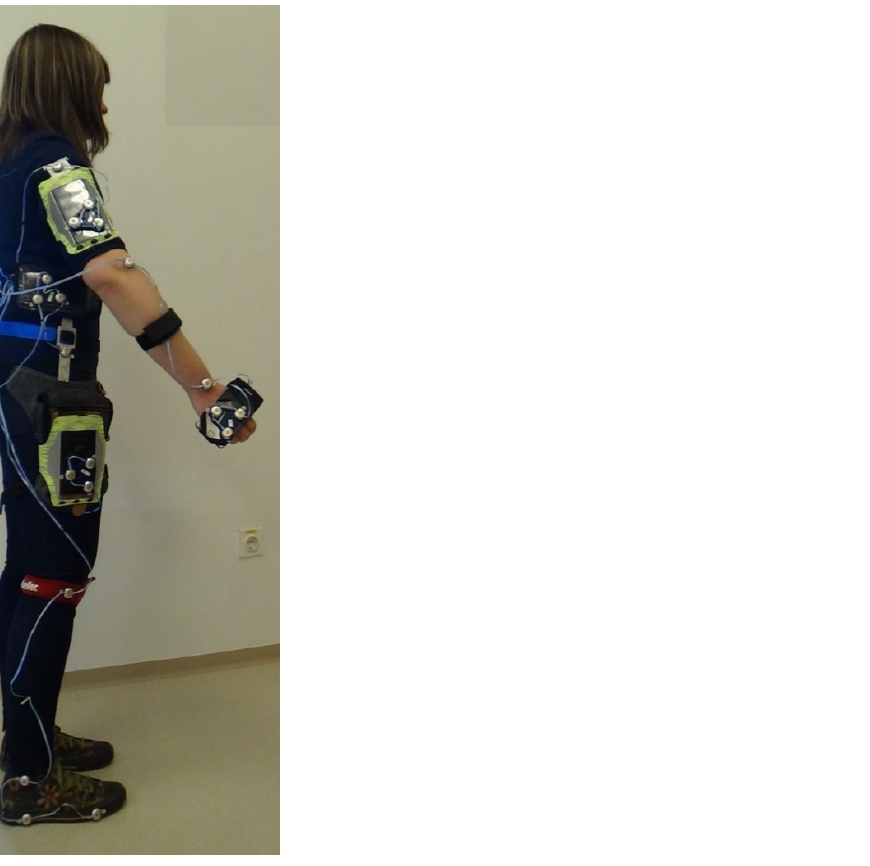
Figure 3. Optotrak’s infrared markers attached to anatomical landmarks of the human body and four smartphones.